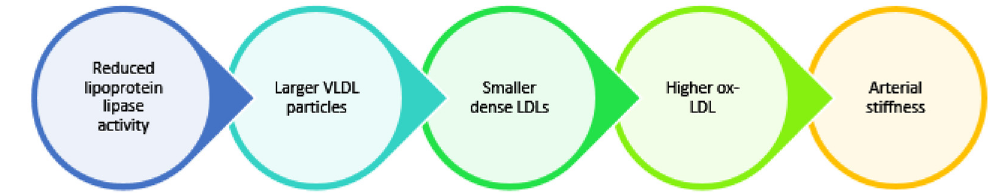
Figure 3. VLDLs and arterial stiffness (VLDL: very low-density lipoprotein, LDL: low-density lipoprotein, ox-LDL: oxidized-low-density